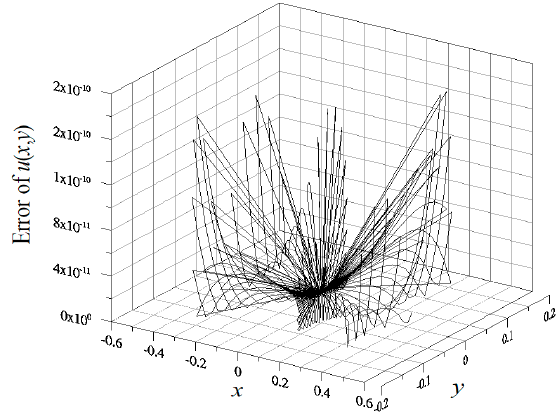
Figure 3. The numerical errors of the proposed solution method for the steady-state AC equation with peanut-shaped domain.